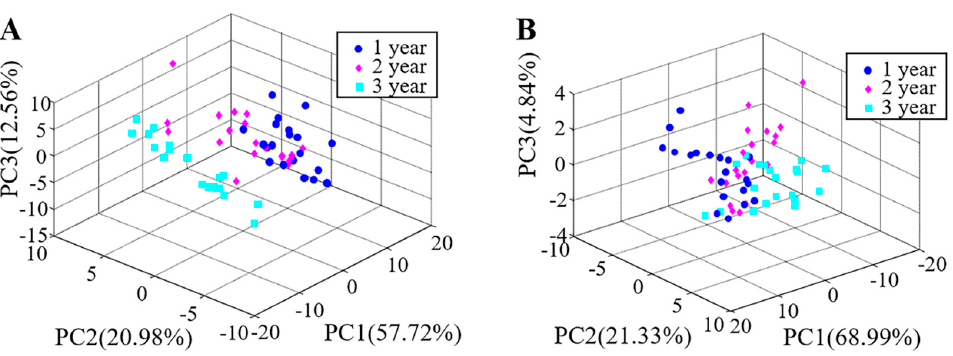
Figure 4. Classification results by principal component analysis (PCA) in different reaction chambers. ( A ). The new reaction chamber; ( B ). The free gas volatile reaction chamber.